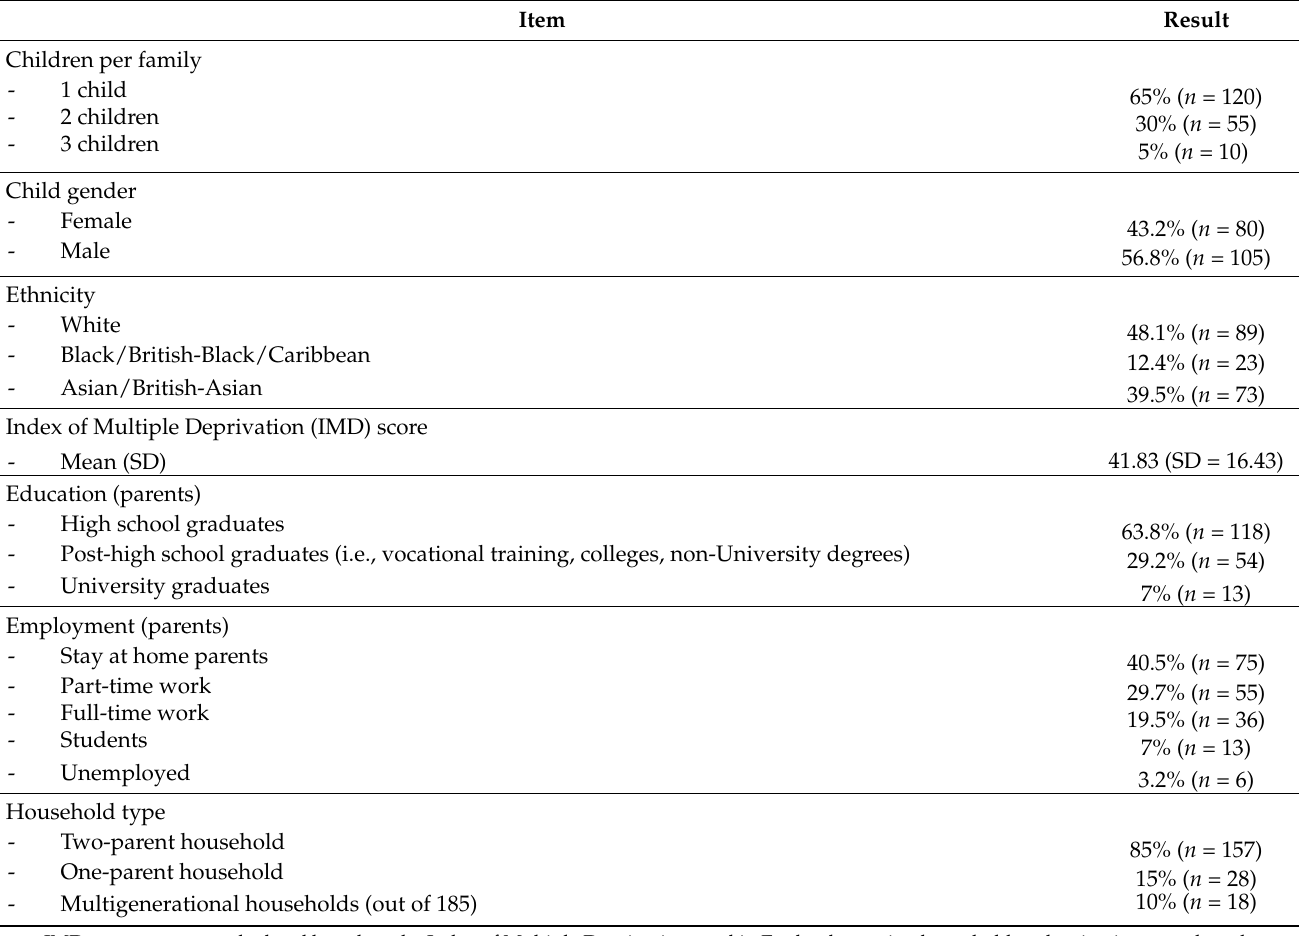
Table 1. Demographic characteristics of the sample.